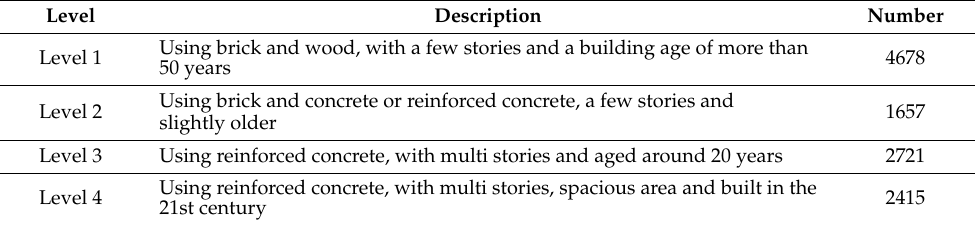
Table 1. Classification description of architectural features for four types of vulnerability curves.